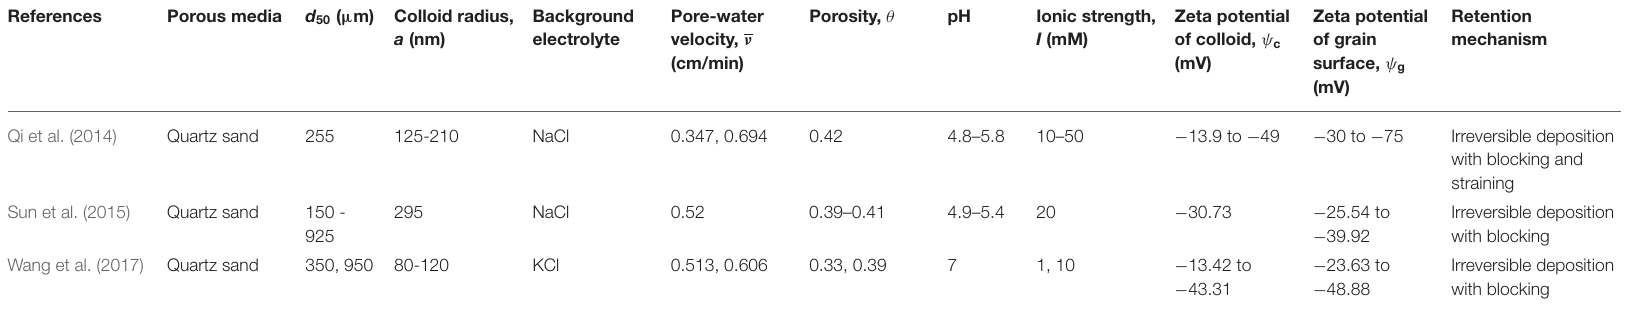
TABLE 3 | Experimental conditions in papers selected to analyse deposition of GO NPs.